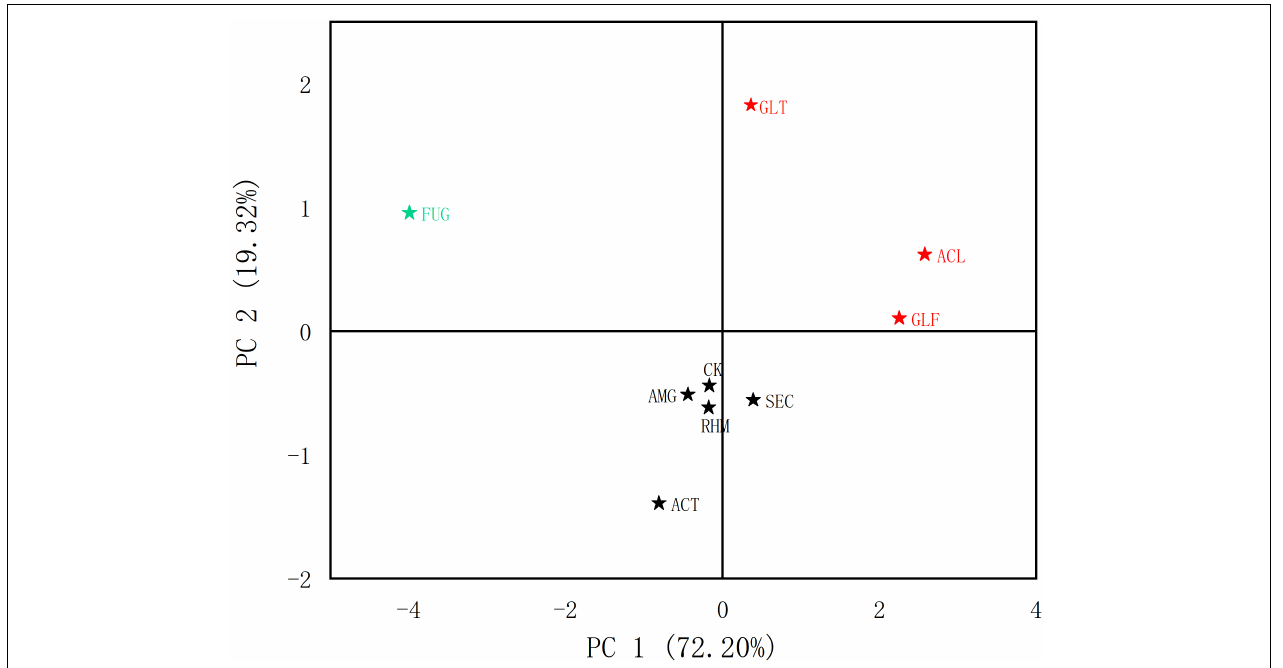
FIGURE 5 | Diagram of HCA of different AMF treatment groups (phenolic